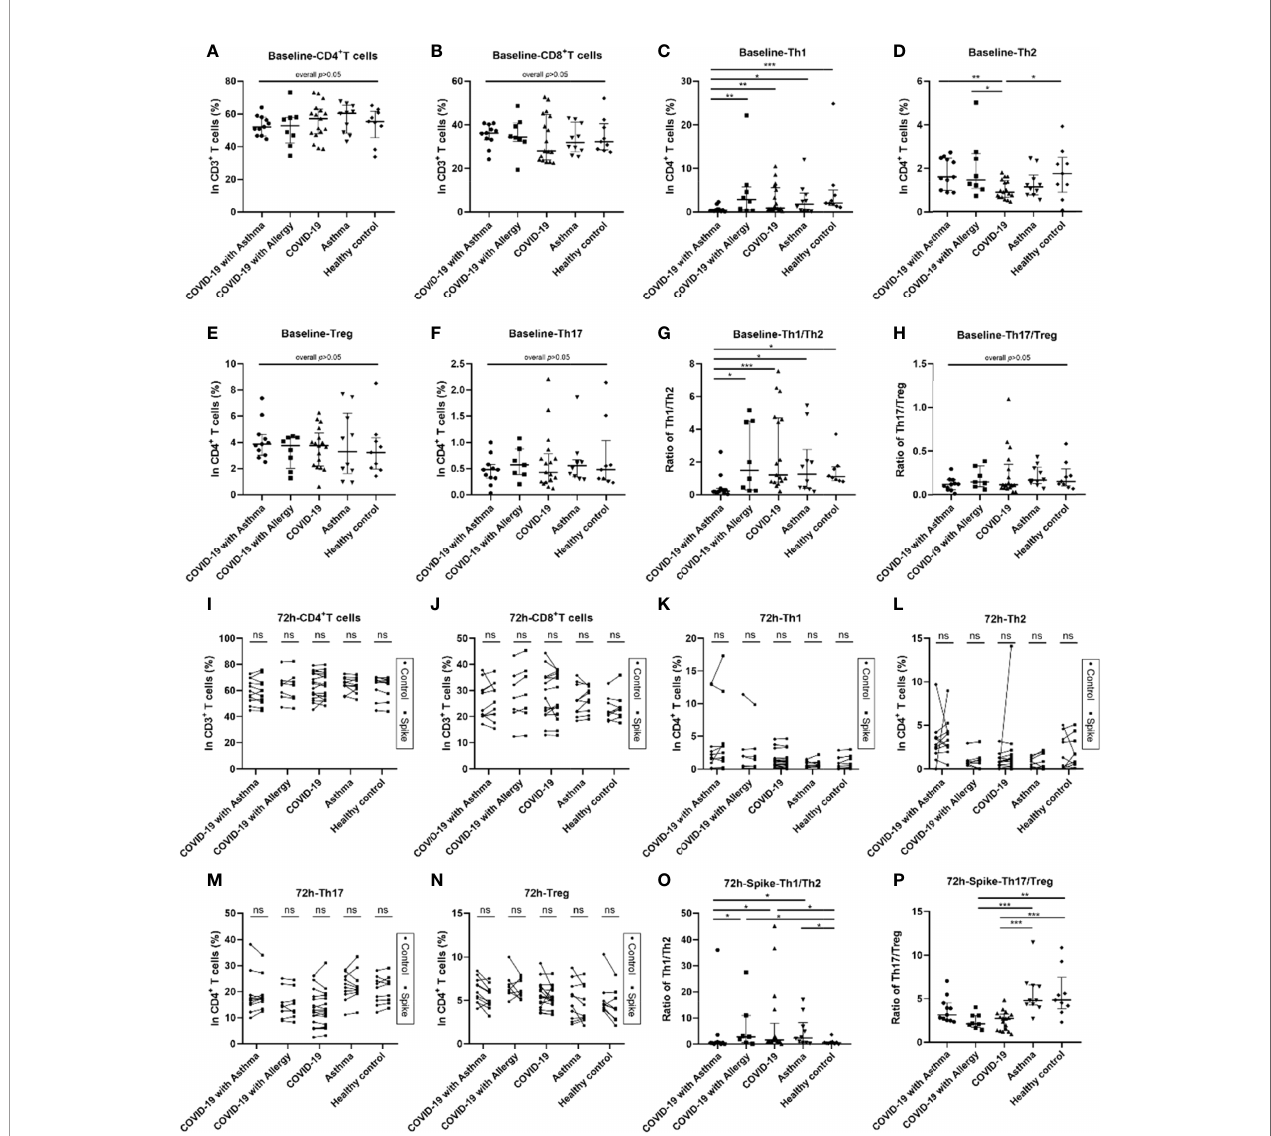
FIGURE 1 | Blood lymphocyte subsets at baseline and 72 hours after SARS-CoV-2 Spike peptide pools stimulation among COVID-19 groups with/without asthma or allergy. Analysis of blood lymphocyte subsets in COVID-19 with asthma group (n = 11), COVID-19 with allergy group (n = 8), COVID-19 group (n = 17), asthma group (n = 10) and healthy control group (n = 9). Lymphocyte subsets were detected by fl ow cytometry for CD4 + T cells, CD8 + T cells, Th1 cells, Th2 cells, Th17 cells, and Treg cells at the baseline (A – H) and 72 hours after stimulation by SARS-CoV-2 Spike peptide pools or PBS control (I – P) . The percentages of and the ratios of CD4 + /CD8 + , Th1/Th2, and Th17/Treg in the fi ve groups were analyzed. Data were tested using the Kruskal-Wallis test and Dunn ’ s test. Control and spike peptide pools stimulation groups were compared using Wilcoxon Matched-Pairs signed rank test. * p < 0.05, ** p < 0.01, *** p < 0.001, ns, not signi fi